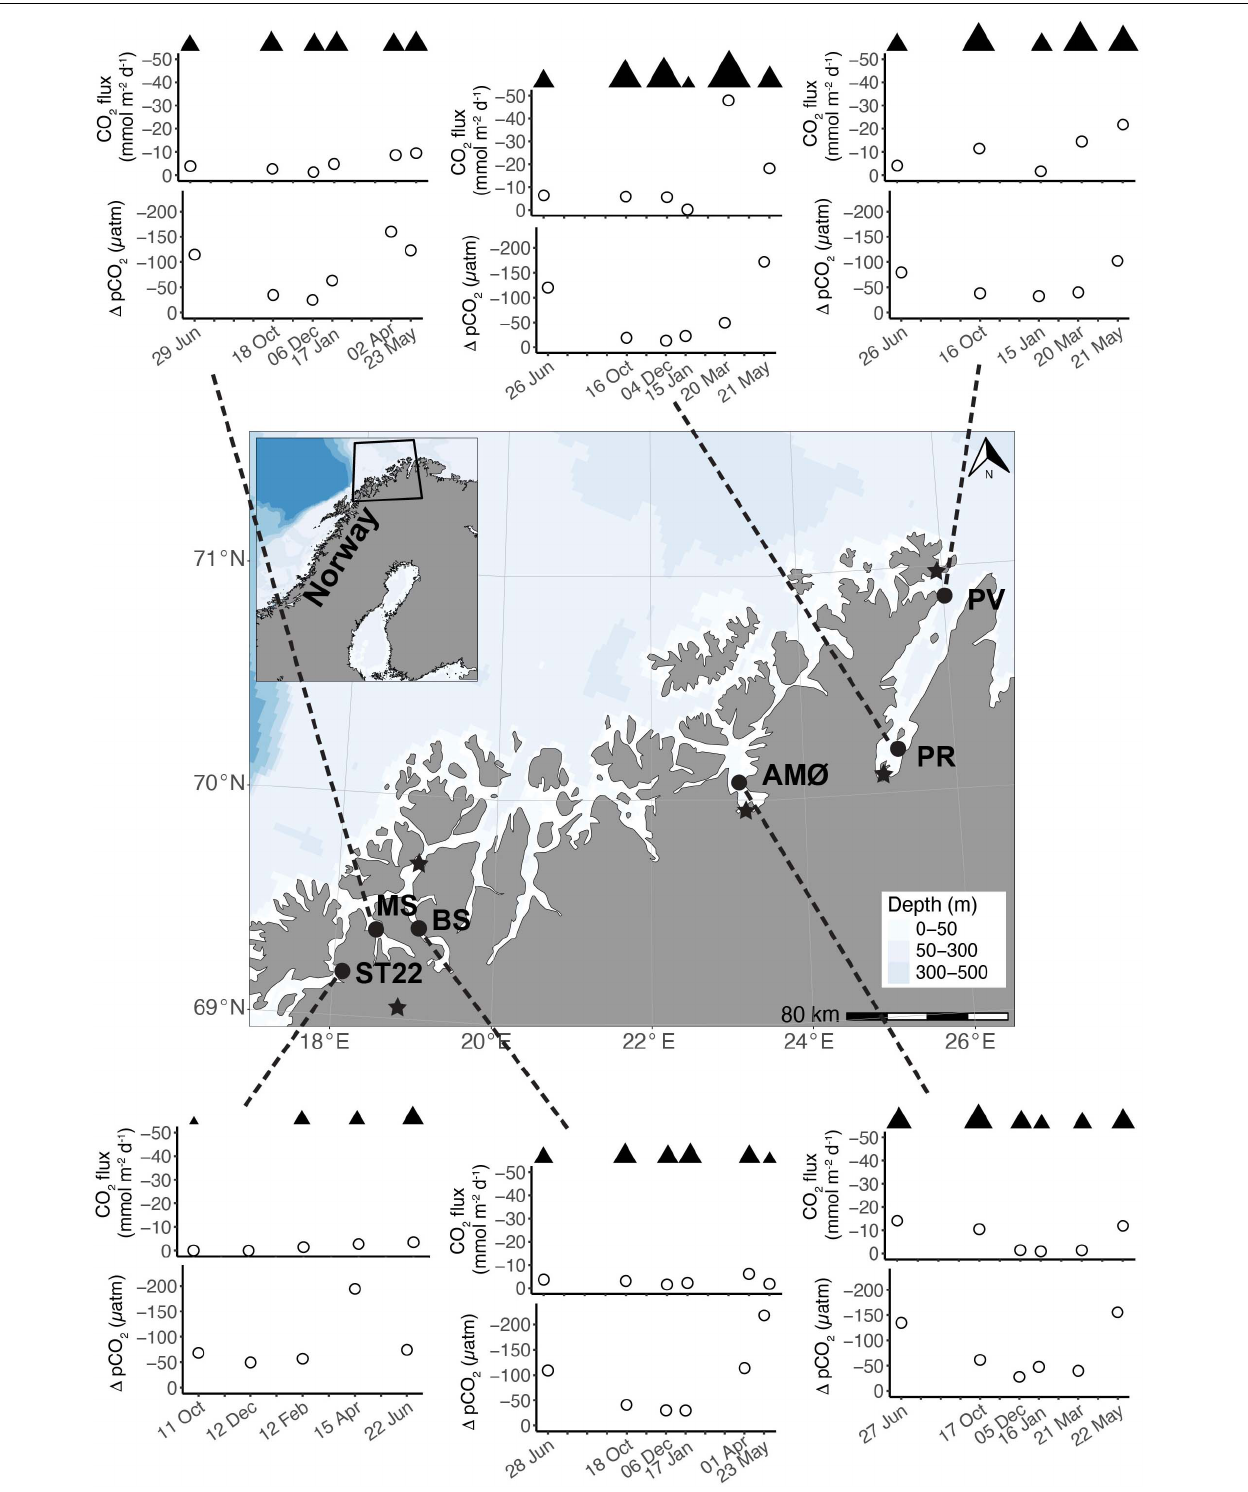
FIGURE 1 | Map of investigated study area along the coast of northern Norway and time series of CO 2 flux (mmol m − 2 d − 1 ) and (cid:49) pCO 2 ( µ atm) between June 2018 and 2019. Note different sampling months at ST22. Wind speeds > 1 m s − 1 are marked with (cid:78) above CO 2 flux as relative difference between stations and sampling events. Map: location of stations; PV and PR in Porsangerfjord, AMØ in Altafjord, BS in Balsfjord, MS in Malangen Fjord, and ST22 in Finnfjord Indre. Meteorological stations are indicated with (cid:70) .